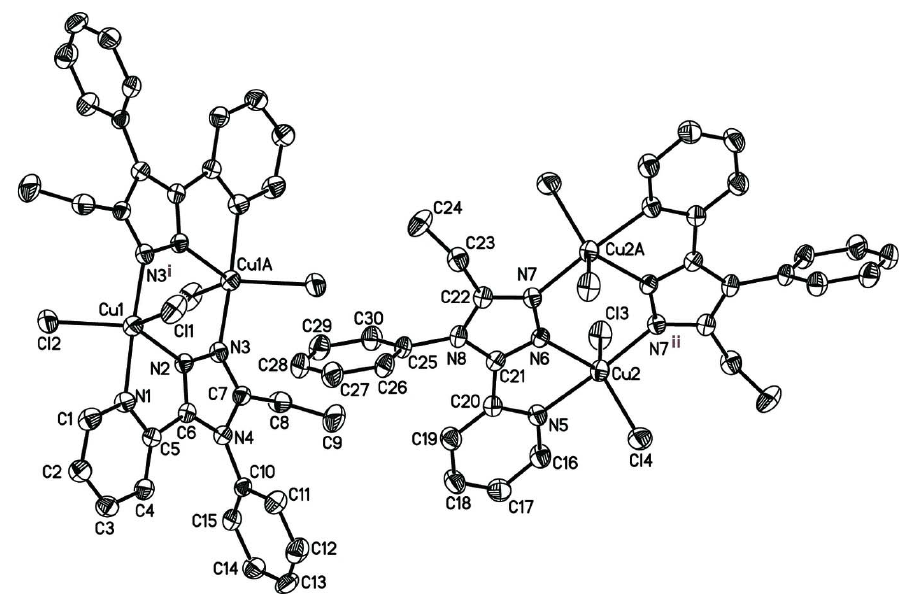
Figure 1 View of (I) with the atomic labelling and 30% probability displacement ellipsoids [symmetry codes: (i) - x + 1,- y + 2,- z ; (ii) - x ,- y + 1,- z +